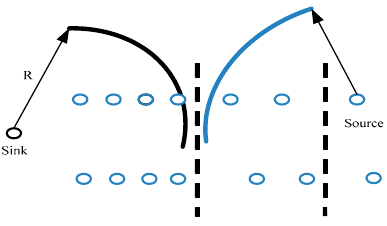
Figure 2. Node communication radius.